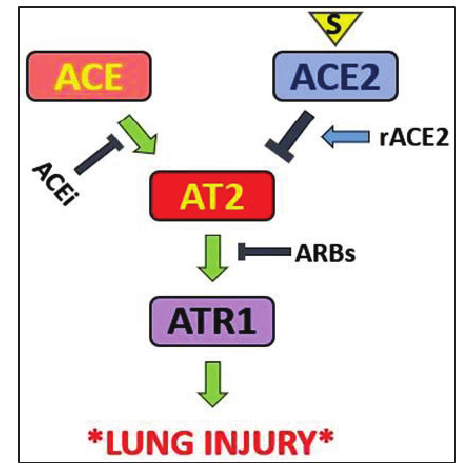
Fig-B: Schematic role of RAAS components (ACE, ACE2, AT2, and ATR1) in acute lung injury and sites where RAAS antagonists (rACE2, ACEi, and ARBs) block the inflammatory pathway and attenuate inflammatory lung injury. S (yellow triangle) = Spike Glycoprotein of SARS-CoV2. ACE2 counter balance ACE and subsequent pathway by deactivating AT2. rACE2 = recombinant ACE2, can potentiate activity of